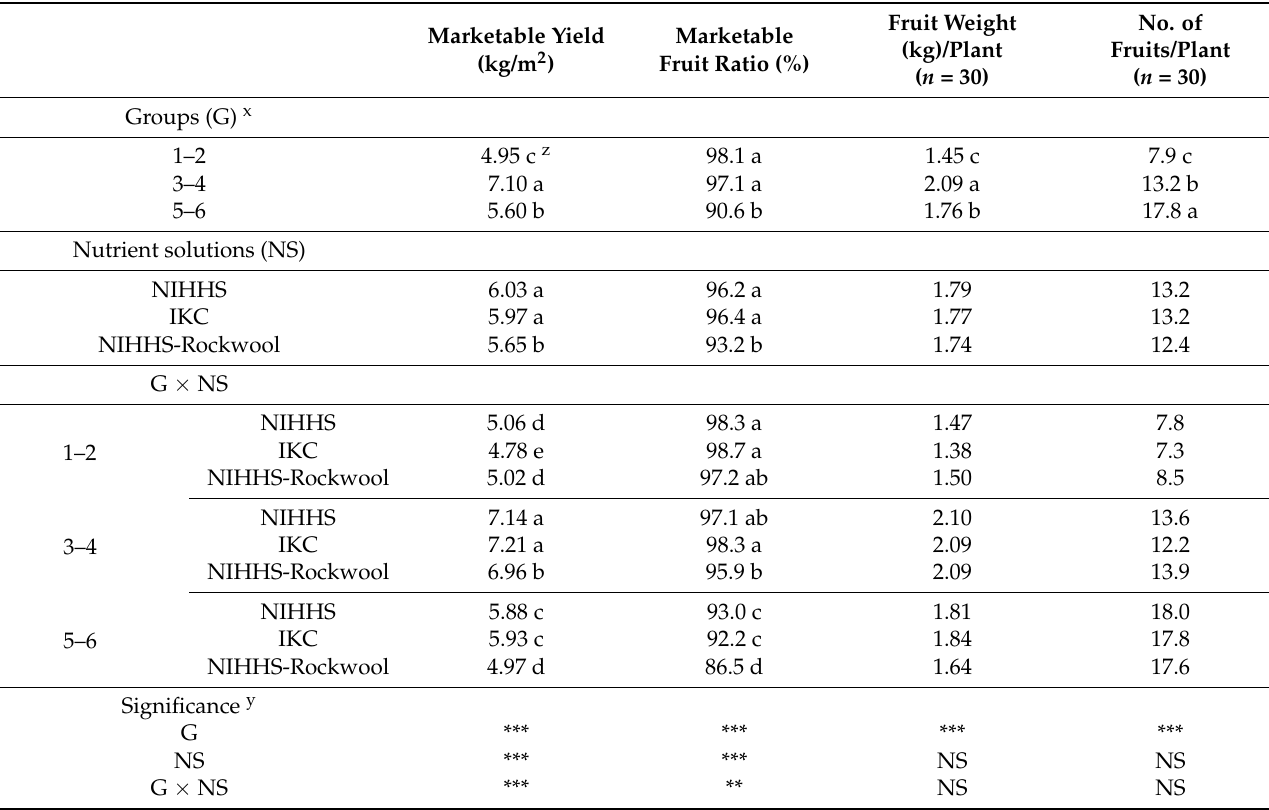
Table 3. Marketable yield characteristics of paprika ‘Cupra’ affected by the compositions of the nutrient solutions, NIHHS, IKC, and PHRS-Rockwool in Experiment 1, according to growth stages during the winter cropping season in a closed hydroponic system with a coir substrate. No. of Fruit Weight Marketable Yield Marketable Fruits/Plant (kg)/Plant (kg/m 2 ) Fruit Ratio (%) ( n = ( n = 30)